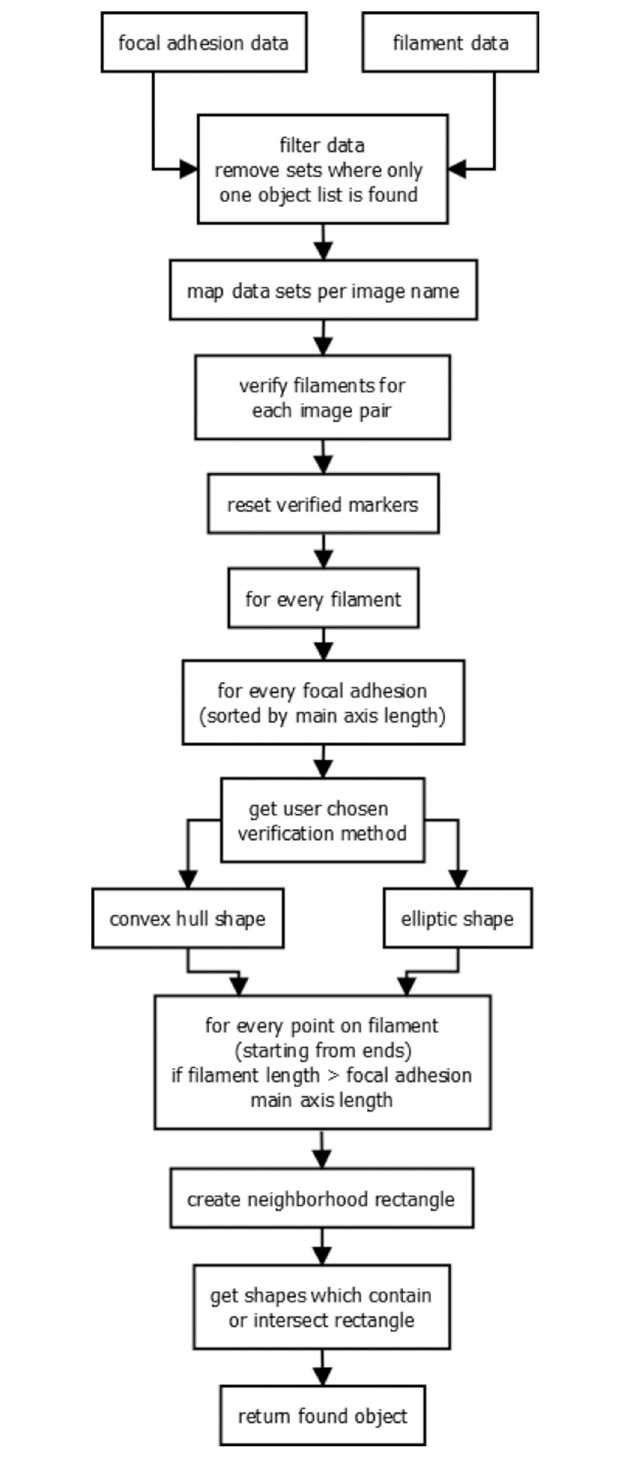
Fig 7. Workflow for correlation in